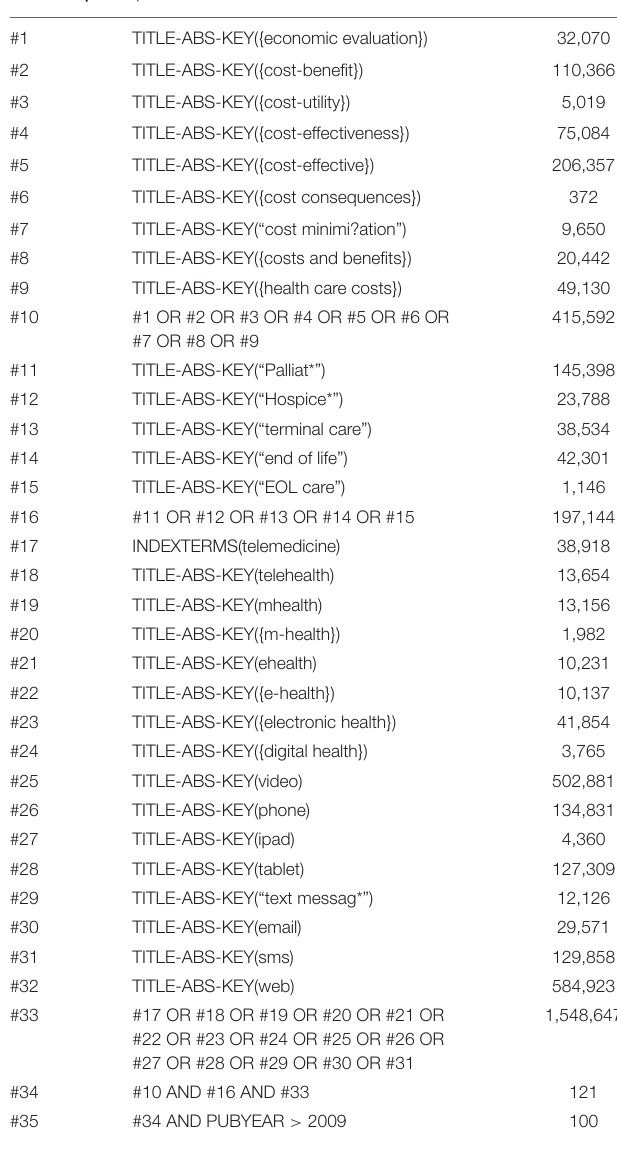
TABLE 1 | Example of full